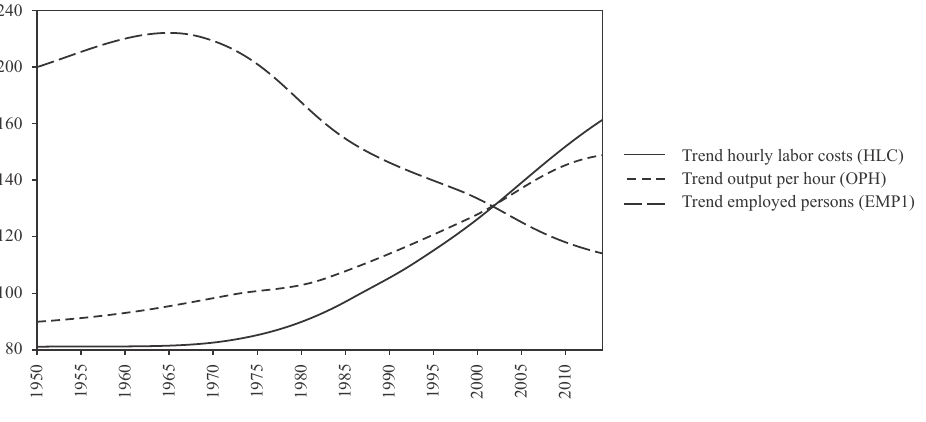
Fig. 2b. The great decoupling in UK